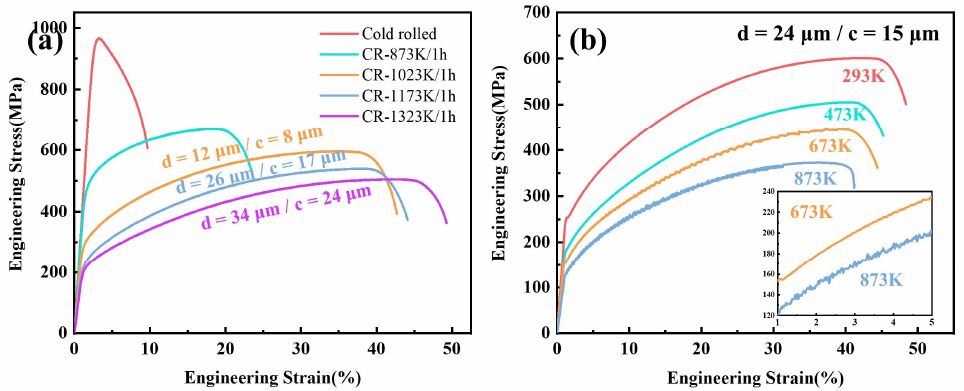
Figure 6. Representative tensile engineering stress–strain curves of Ni 2 CrFe alloys at ( a ) room tem- perature with different states and ( b ) for a grain and crystallite size of 24 μm and 15 μm, respec- tively, at different temperatures. The inset in ( b ) shows a serrated flow after yielding for the curve obtained at 673 K and 873 K.